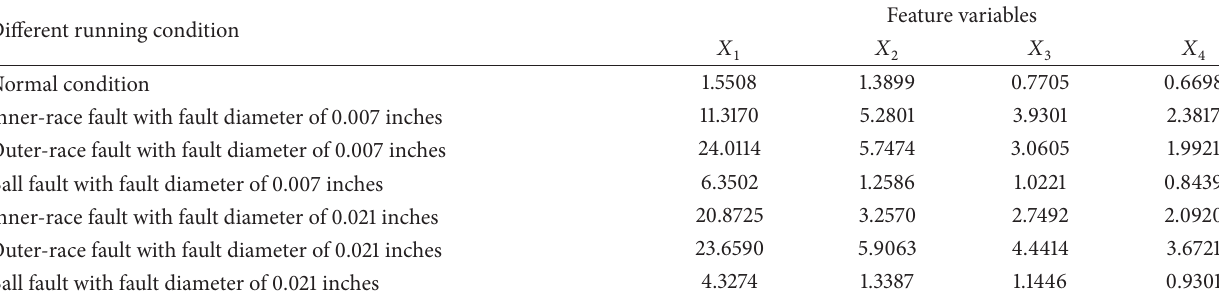
Table 4: Feature variables of seven conditions of vibration signals.